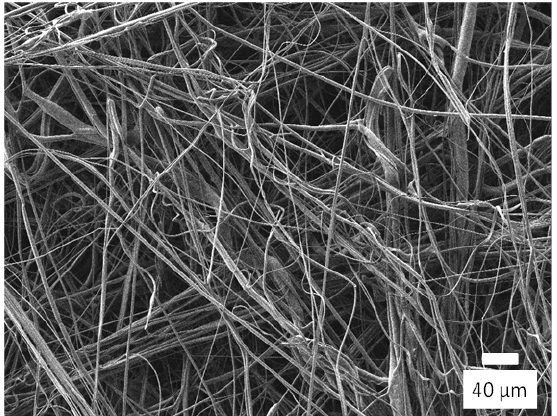
Figure 16. SEM image of meltblown nonwoven fabric sheet in Figure